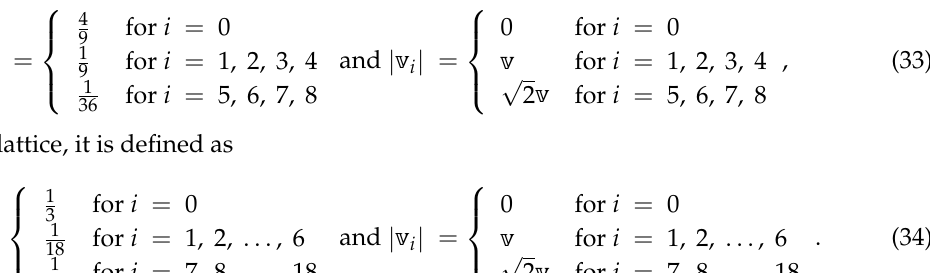
Figure 1. Two typical lattices often used in LB simulations: ( a ) D2Q9; and ( b ) D3Q19.